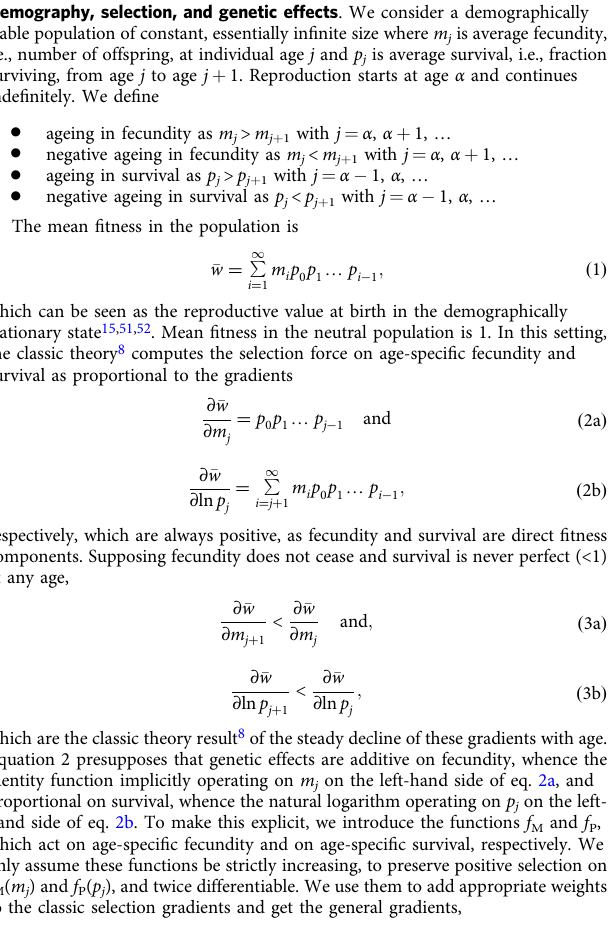
Demography, selection, and genetic effects . We consider a demographically stable population of constant, essentially in fi nite size where m j is average